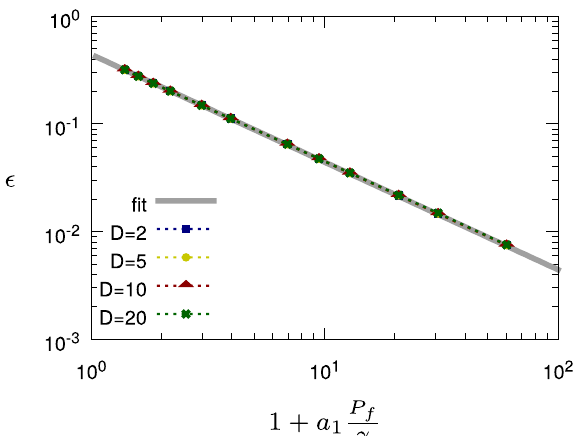
Figure 1. Dephasing channel (“Dephasing channel” section): Control error scaling with respect to the signal- P f /γ for different values of D . For the parameters involved in the simulations, we have to-noise ratio S / N ∝ 1 , ω 2 π 0.5 . Then, in each iteration of the optimization, the noise 2 π 0.5 , ω chosen the values T z = y = = × × strength γ is chosen as a function of the control pulse power P f to set the value of S / N . The data points plotted 2 , blue in the figure represent the minimum error from 10 optimization runs for each value of D , namely ( D = 5 , yellow circles), ( D 10 , red triangles), and ( D 20 , green crosses). Finally, the fit curve (grey squares), ( D = = = 0.0754 and b 1 0.443 line, ‘fit’) is the result of the fit provided by Eq. (59) in the main text, with a 1 = =